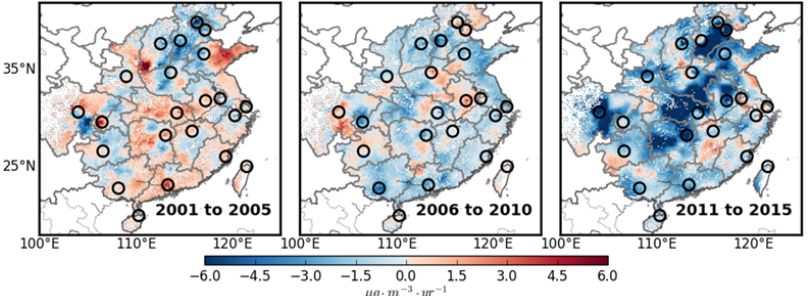
Figure 5. Spatial distributions of PM 2.5 trends in the residential area of the study region during the 10th, 11th, and 12th FYP periods. The locations of the capital cities of the provinces are marked by circles.